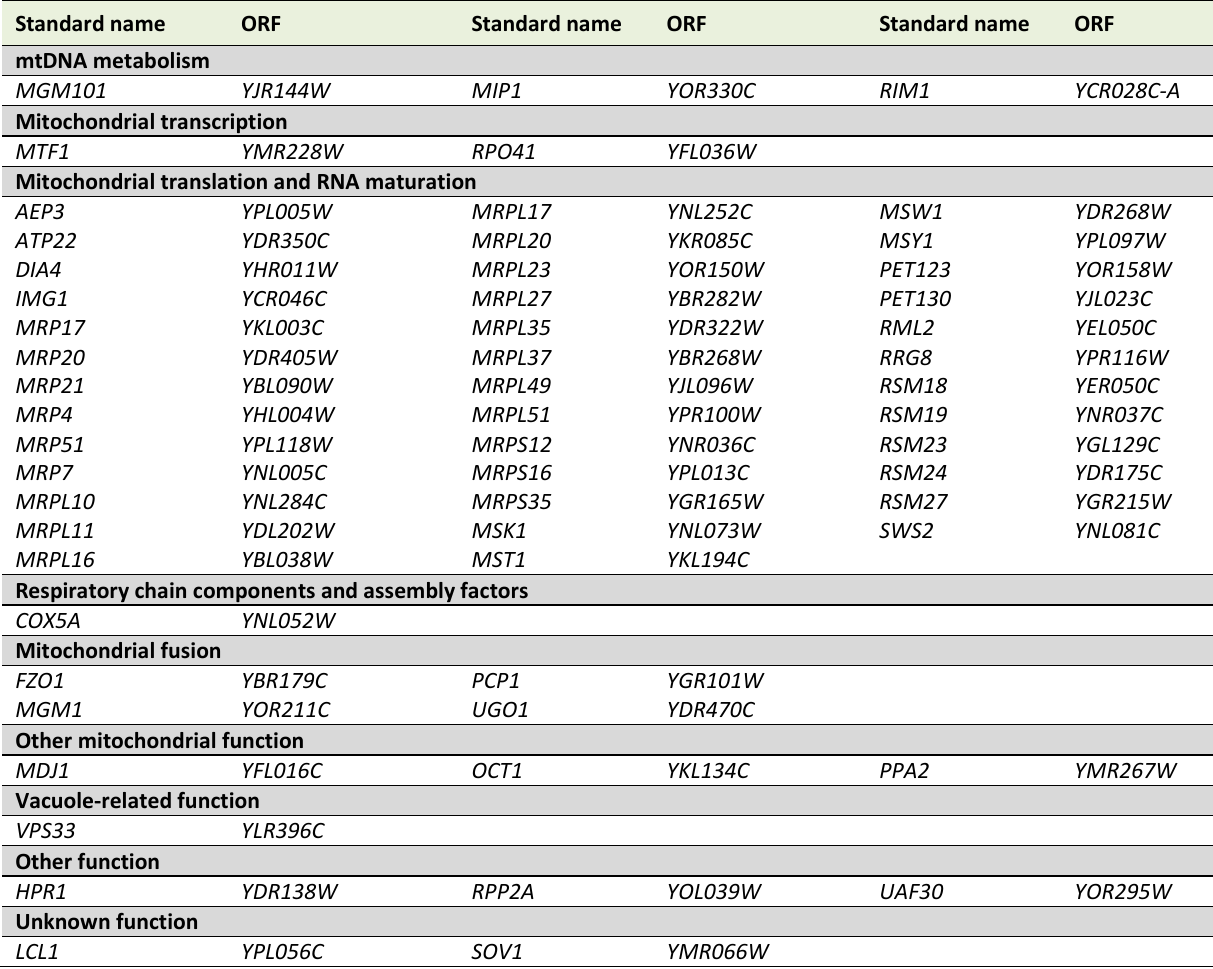
TABLE 4. Genes required for maintenance of [ ARG8 m ] mtDNA. The yeast deletion collection was treated as outlined in Fig. 3A, and mu- tants showing an instable mtDNA phenotype were confirmed by DAPI staining. This table is an excerpt of Table S6. Genes with known functions in arginine biosynthesis or mating and dubious ORFs were excluded from this